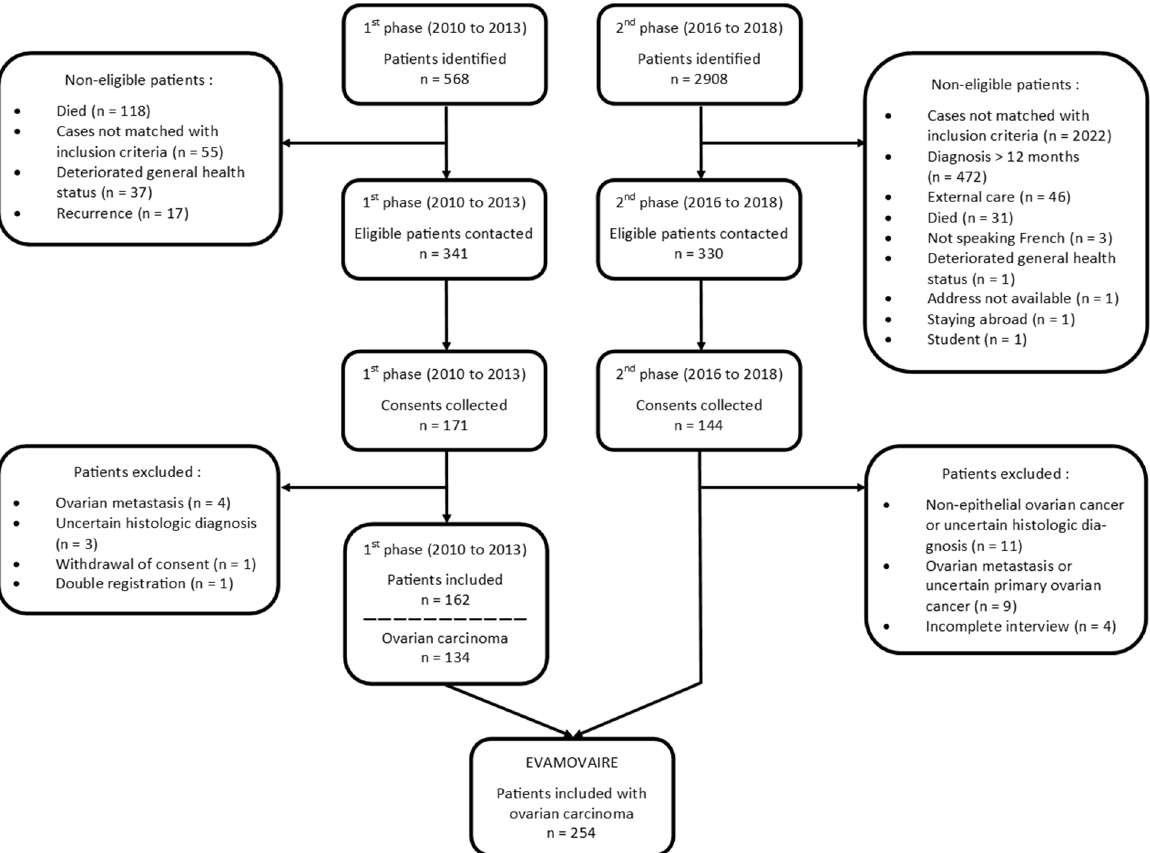
Figure 1. Flowchart. Figure 1.